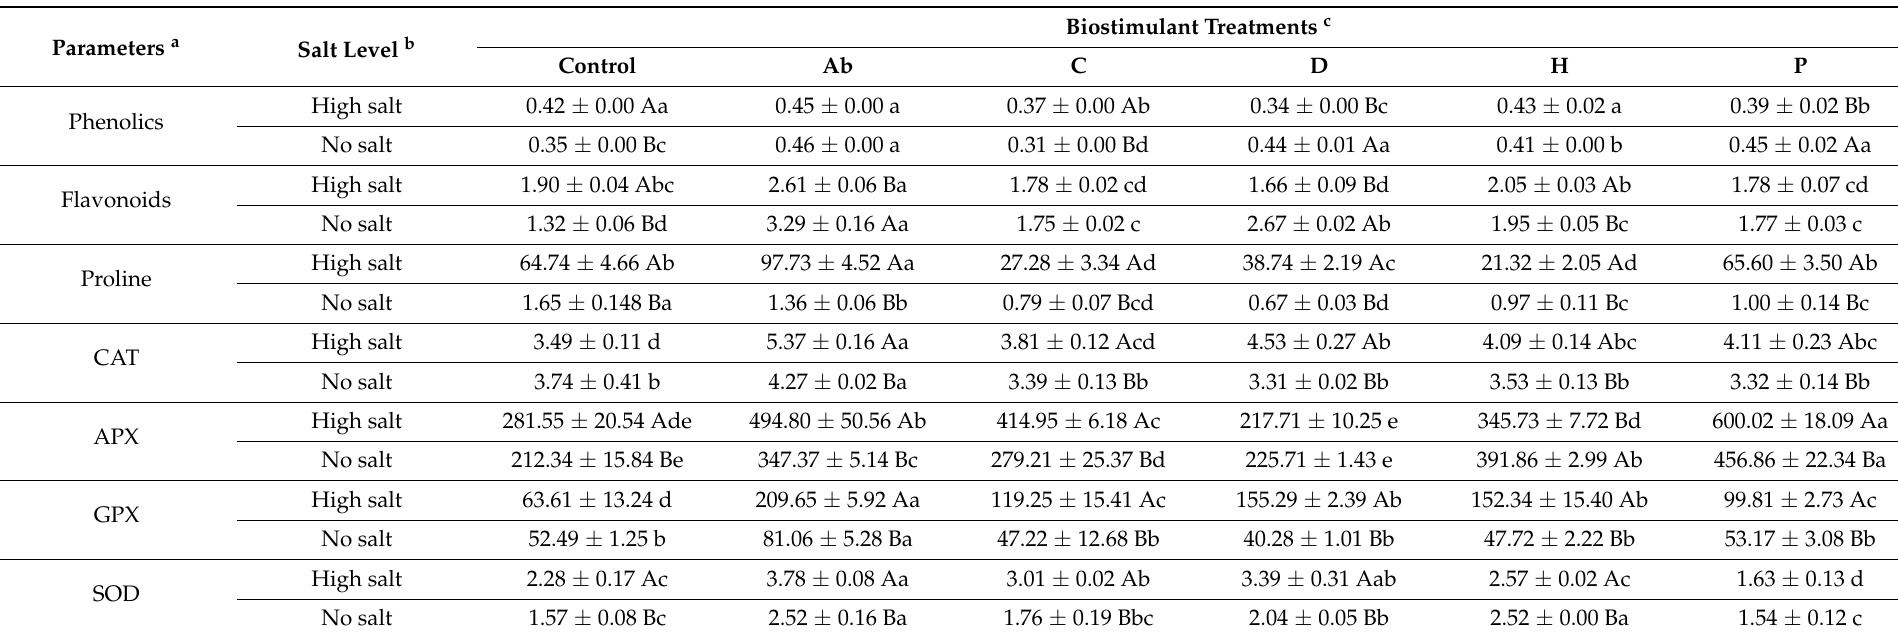
Table 1. Effect of biostimulant application and NaCl concentration on phenolics, flavonoids, proline and antioxidant enzymes in leaves of hydroponically grown tomato